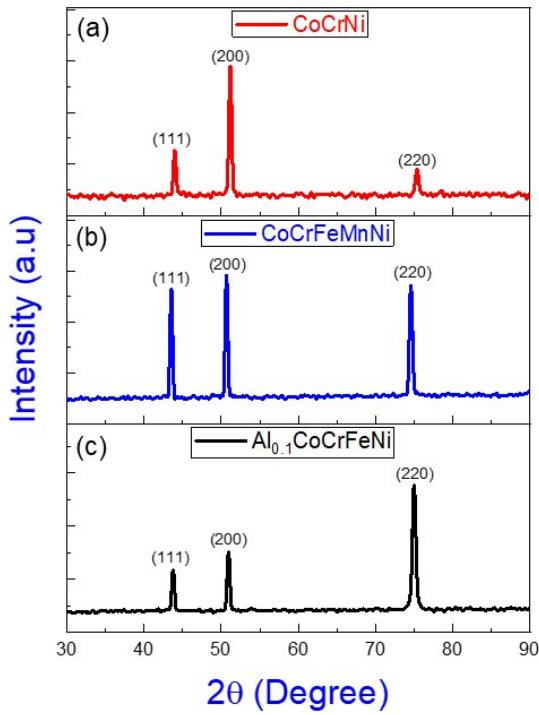
Figure 1. X-ray diffraction (XRD) patterns of multi-principal ( a ) CoCrNi, ( b ) CoCrFeMnNi, and ( c ) Al 0.1 CoCrFeNi alloys.